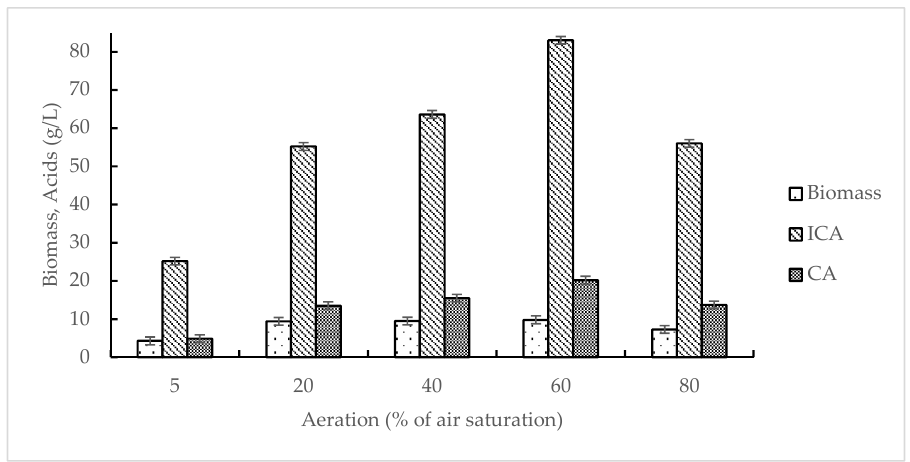
Figure 3. Effect of aeration on the growth of Y. lipolytica VKM Y-2373 and production of isocitric acid (ICA) and citric acid (CA).